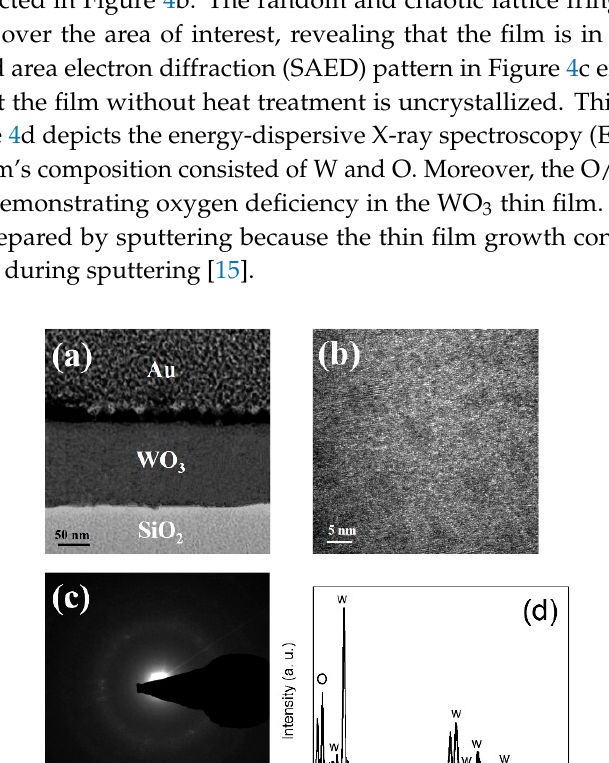
Figure 5. TEM analysis of the WO 3 film annealed at 600 °C: ( a ) low-magnification image, ( b , c ) HR images, ( d ) SAED pattern, ( e ) EDS spectra.